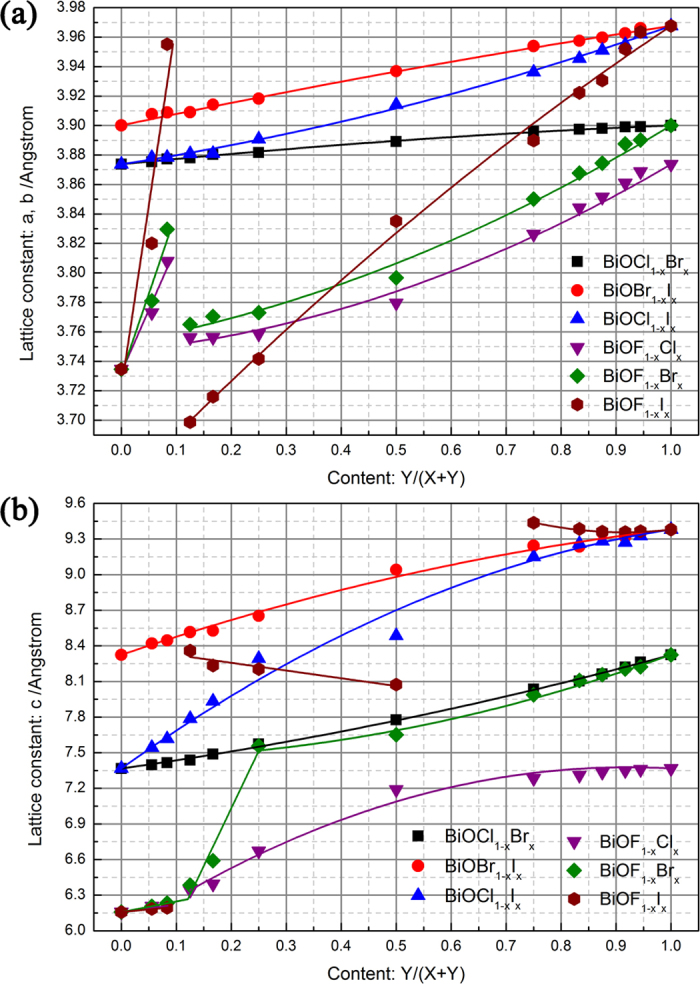
Lattice constants of BiOX1−xYx solid solutions as function of content x.